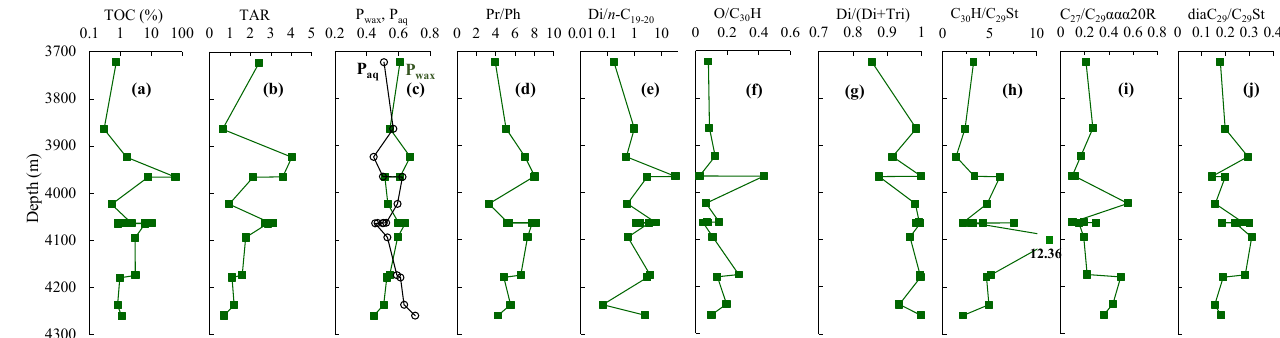
Figure 6. Variation of TOC ( a ), TAR ( b ), P aq ( c ), P wax (c), Pr/Ph ( d ), diterpanes/ n- C 19–20 (Di/ n- C 19–20 ; ( e ), oleanane/C 30 hopane (O/C 30 H; ( f) ), diterpanes/(diterpanes + non-hopanoid triterpanes) [Di/(Di + Tri); ( g )], C 29 steranes/C 30 hopane (C 29 St/C 30 H; ( h )), C 27 /C 29 ααα 20R sterane ( i ), and C 29 diasteranes/C 29 steranes (diaC 29 /C 29 St; ( j )) with depth for the studied source rocks.